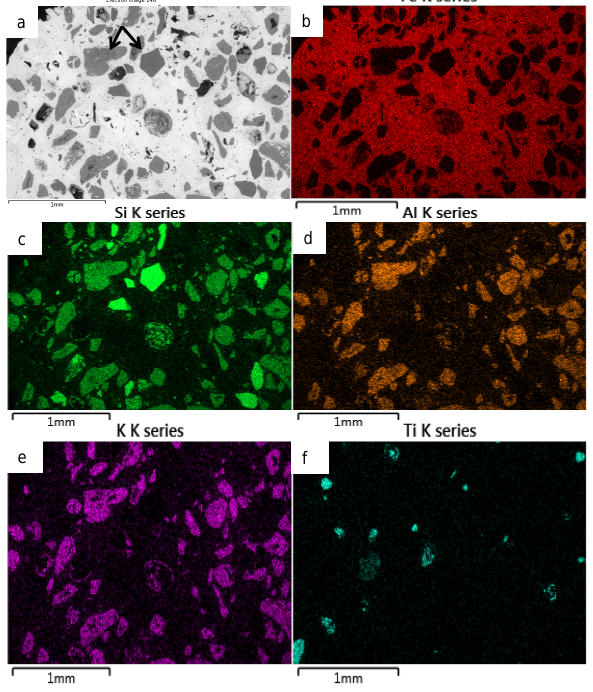
Figure 6. Scanning electron microscope micrograph showing the chemical composition of volcaniclast (arrows in a ) and the iron ce- ment of the CIF overlying the